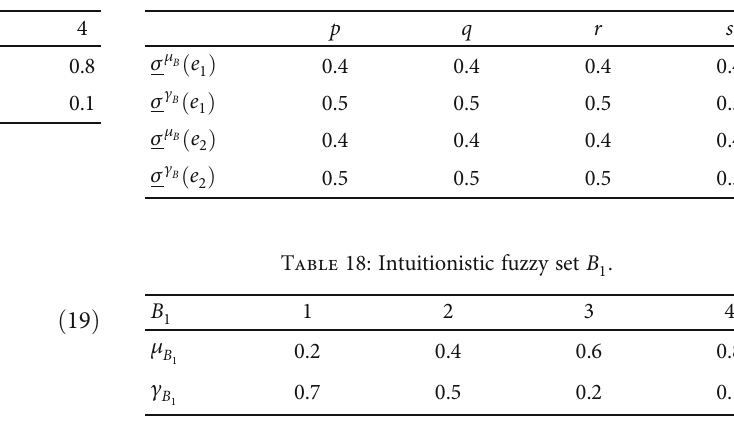
Table 16: Intuitionistic fuzzy set B . Table 17: Lower approximation of B .